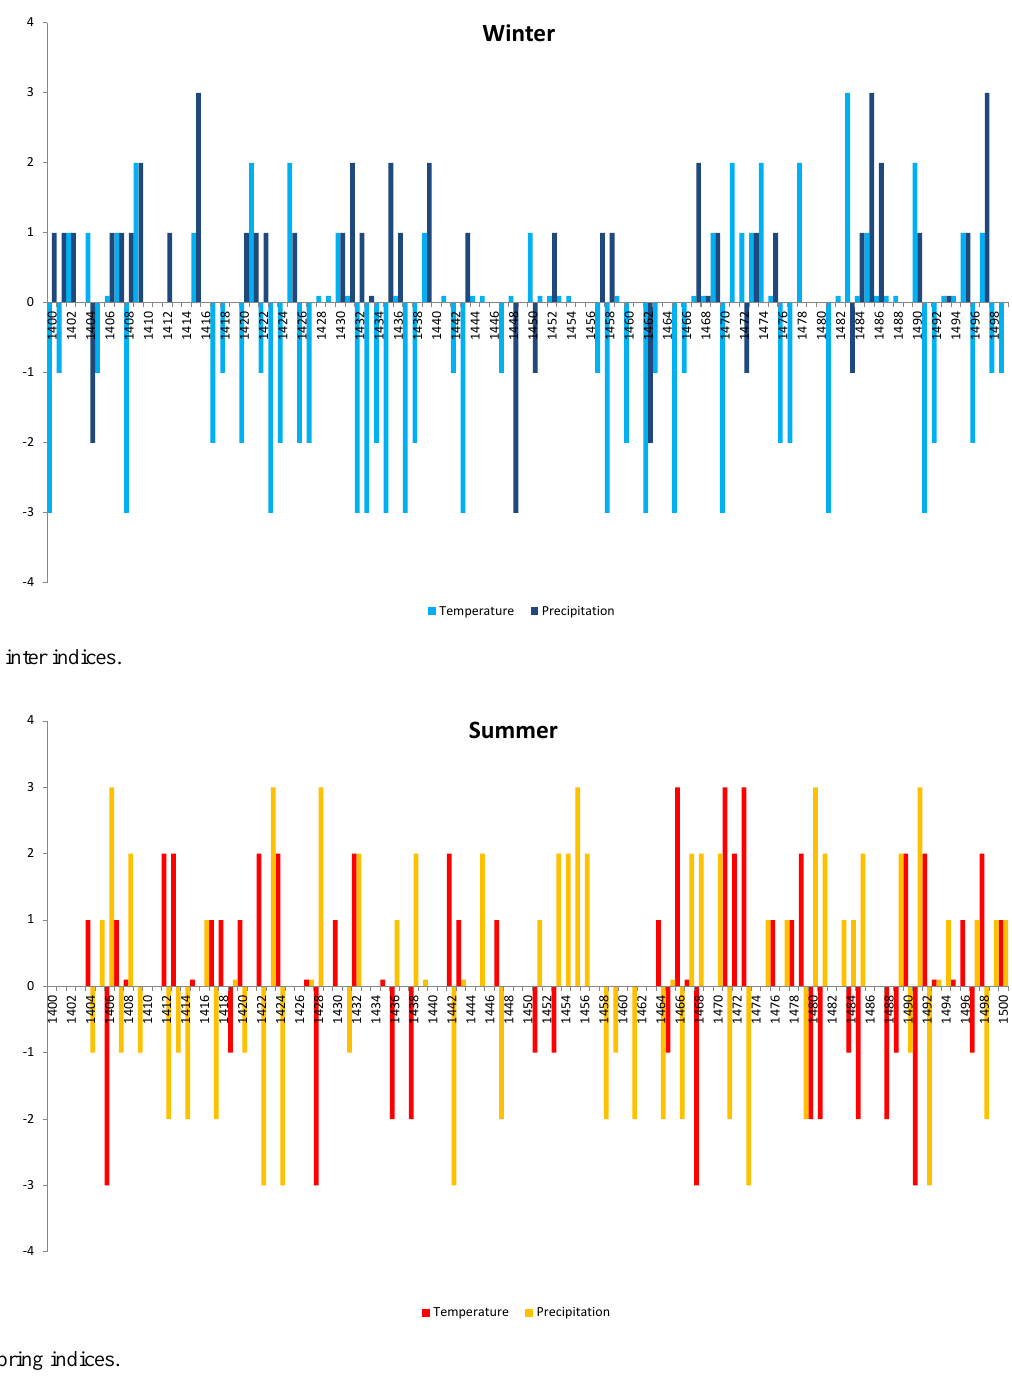
Figure 5. Spring